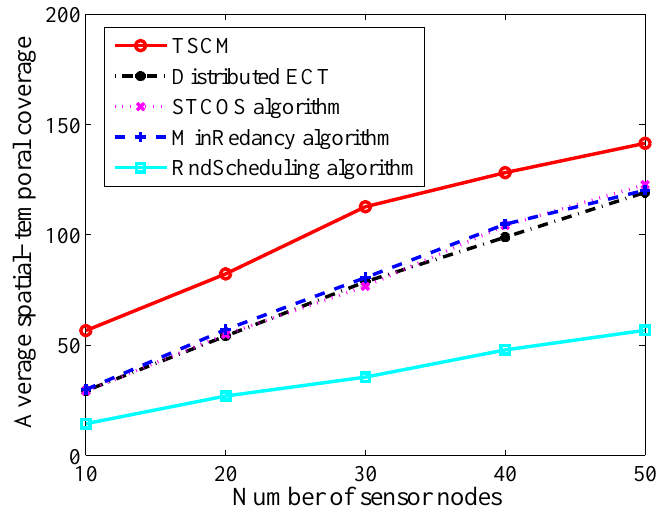
Figure 4. The average spatial-temporal coverage versus different number of sensor